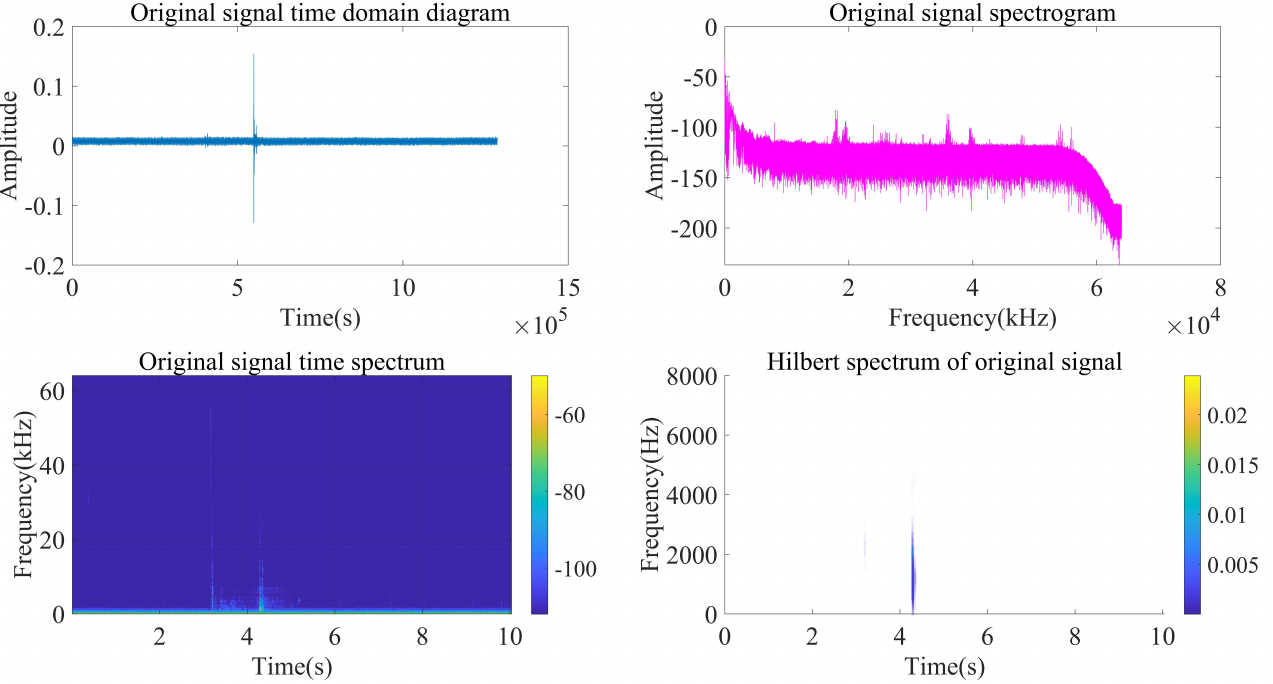
Figure 14. First-channel acquisition signal processing and